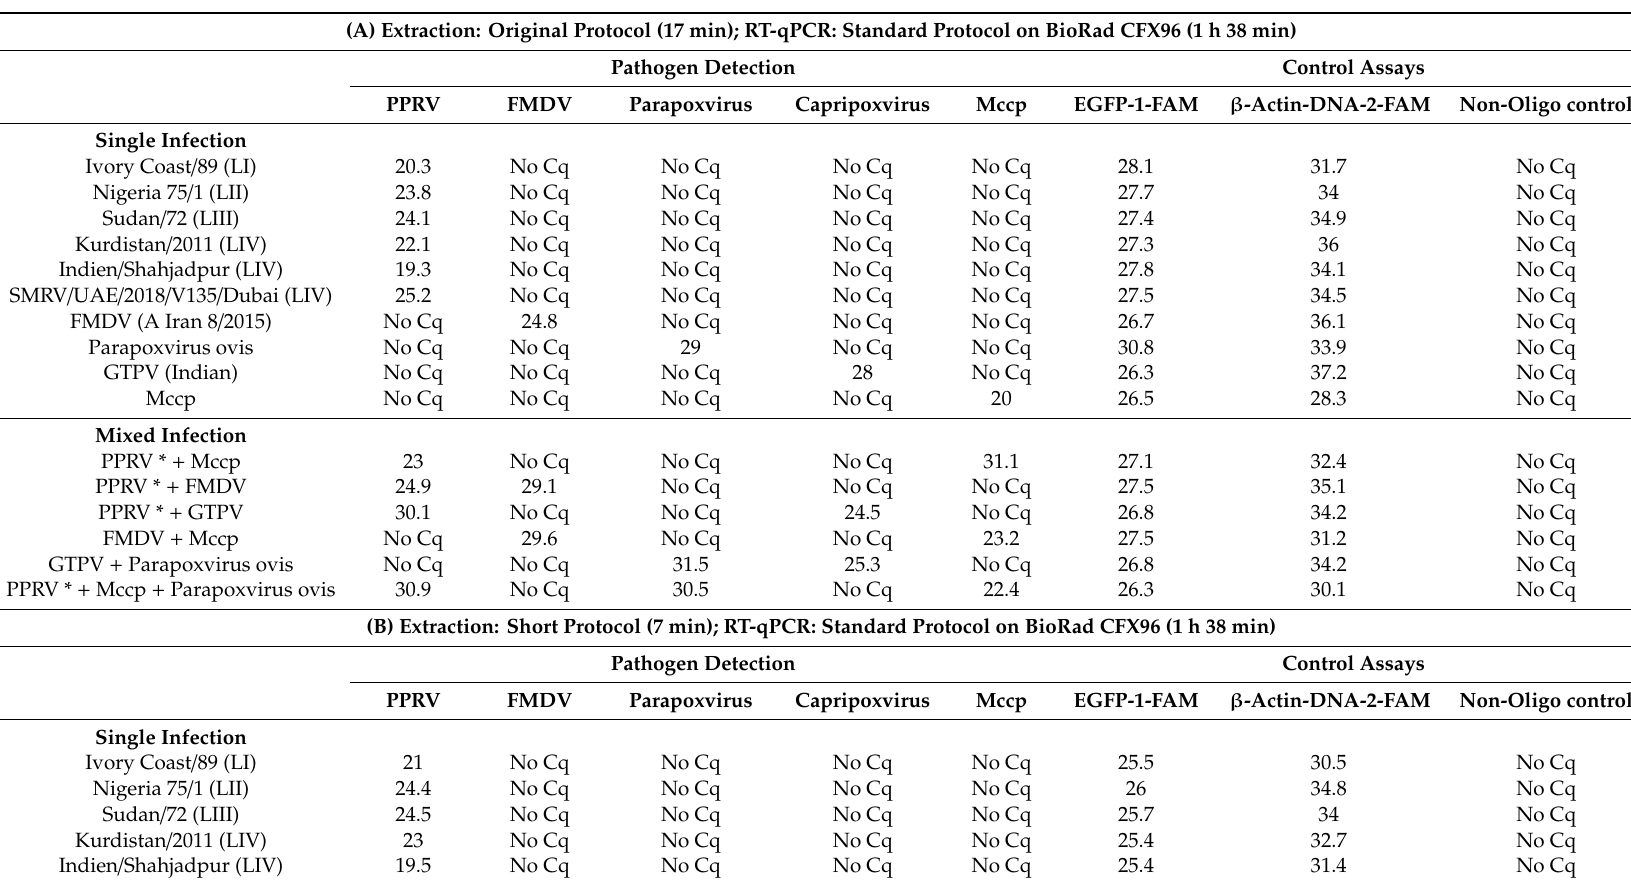
Table 4. Validation of “F ast C heck FLI PPR-like” on the qPCR cycler BioRad CFX96 (results are shown in Cq-values or as “No Cq” for negative results). (A) Extraction: Original Protocol (17 min); RT-qPCR: Standard Protocol on BioRad CFX96 (1 h 38 min)